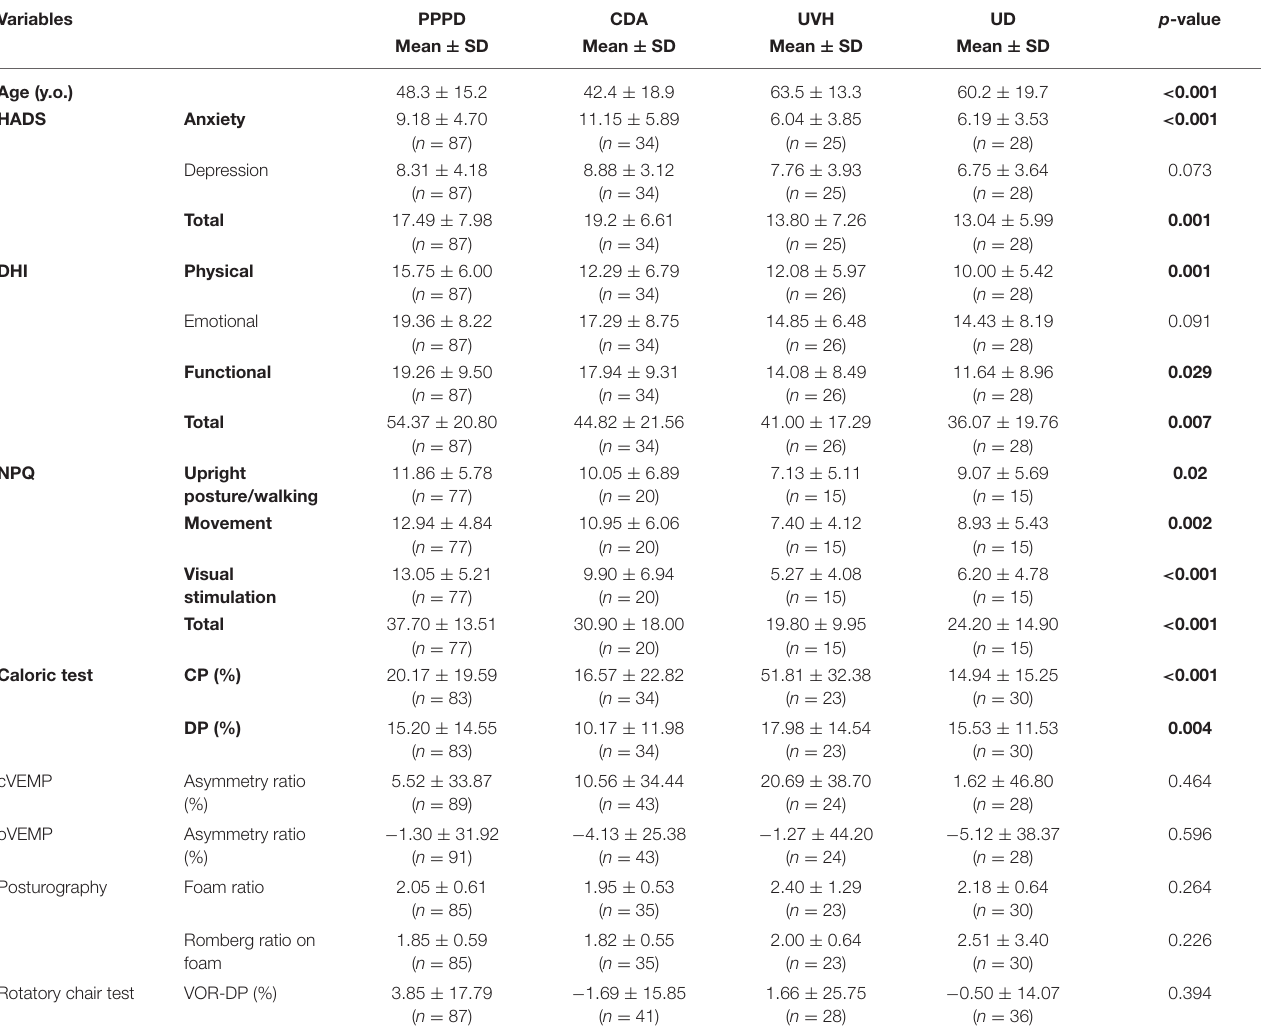
TABLE 1 | Differences in demographic data and results of vestibular tests and questionnaires compared between the four diseases by analysis of variance (Kruskal-Wallis test). Variables